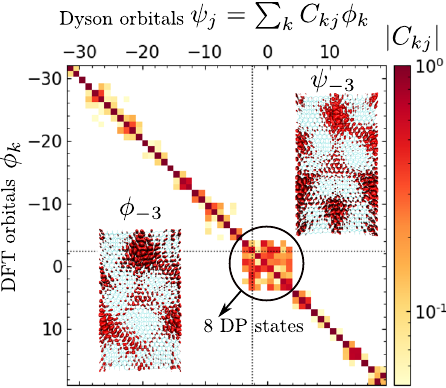
Fig. 3 Exact diagonalization of the quasiparticle Hamiltonian. Coef fi cient matrix obtained from the exact diagonalization of the 51 × 51 H QP at 100 GPa pressure. The absolute values of the complex coef fi cients are plotted. A zero position is set between occupied (negative) and unoccupied (positive) states. With a black circle we indicate 8 Dirac point states that are quasi-degenerate in energy. Inset: We plot a density of state − 3 to compare a KS orbital to the QP orbital. State − 3 is highlighted with a dotted line in the fi